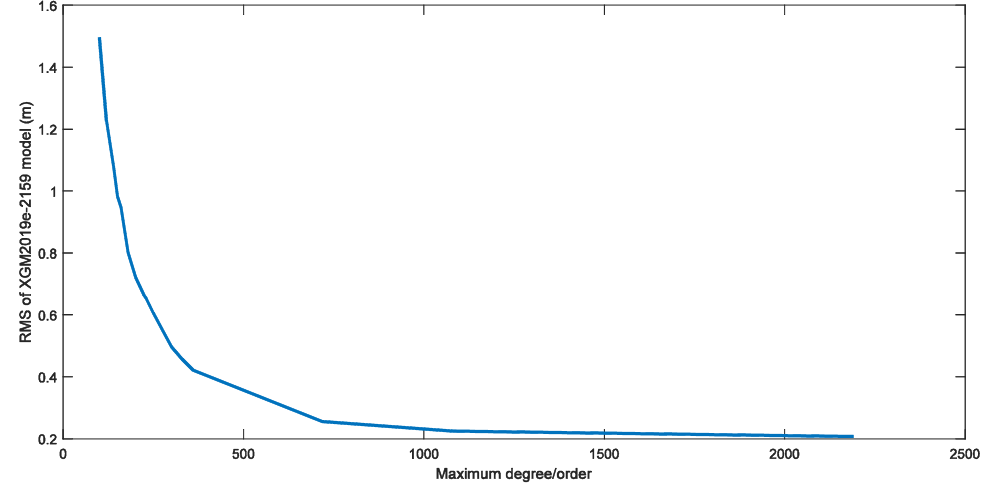
Figure 4 . RMS of the XGM2019e_2159 model at different degrees By sorting Table 1 based on the final accuracy of the GGM's, Table 2 is obtained.